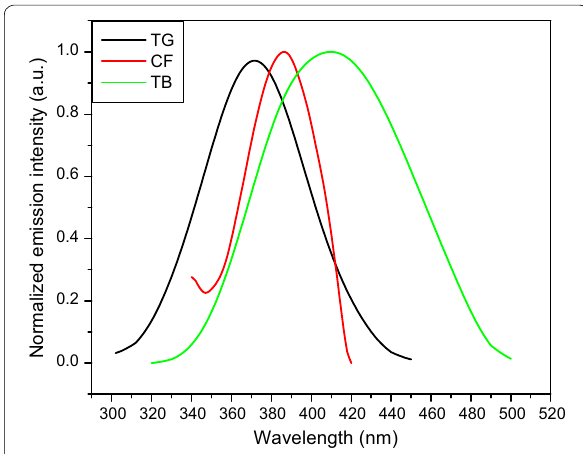
Fig. 3 Fluorescence emission spectra of coffee alkaloid standards dissolved in water. TG trigonelline, CF caffeine, TB theobromine